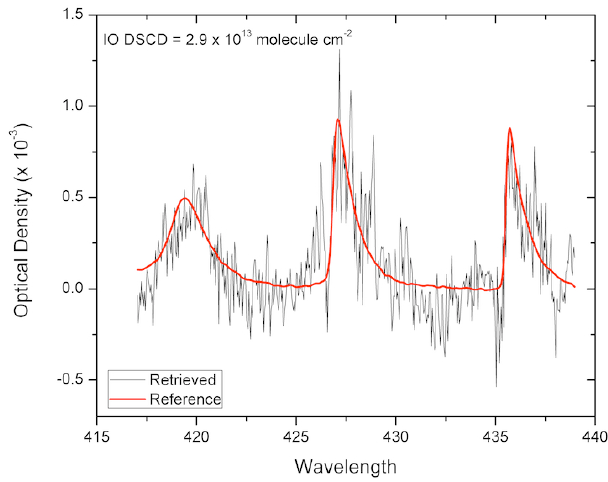
Fig. 2. An example of a DOAS fit for IO during the cruise. This particular fit is from 17 April 2010 at 15:00LT (local